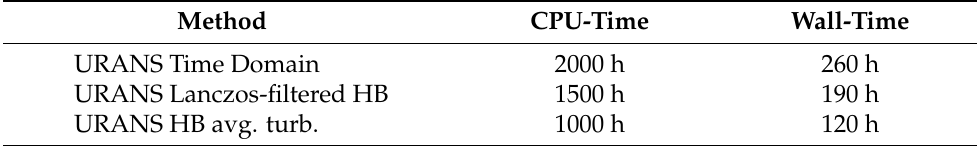
Table 2. Computational resources of the investigated computational solution